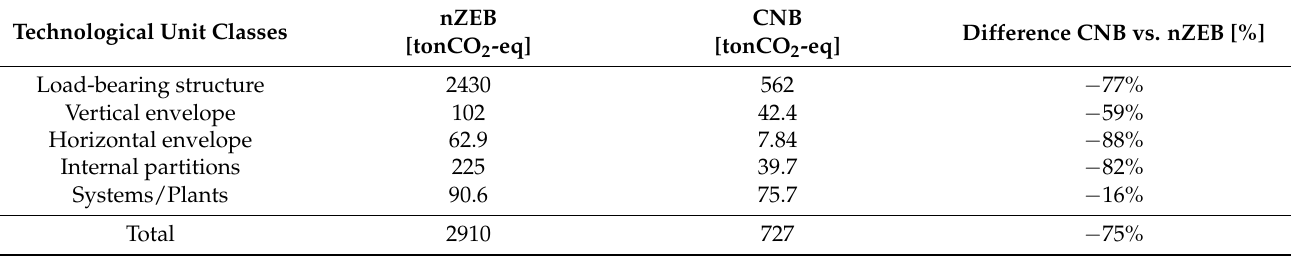
Table 7. Material construction phase analysis and impact comparison (A1–A3) for the CNB and the nZEB scenarios (see Tables A4 and A5, in the Annex, for further